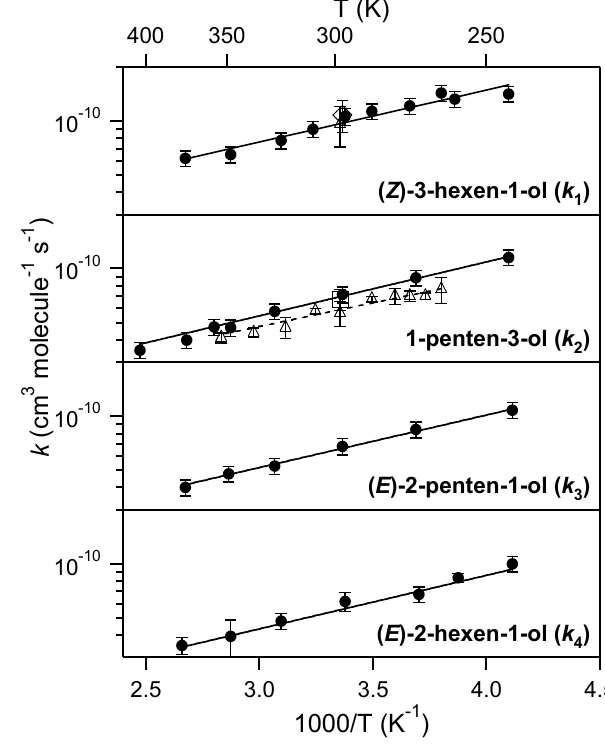
Figure 4 Fig. 4. Temperature dependent rate coefficient data for Reac- tions (R1)–(R4), Arrhenius plot, from this work ( • ). The error bars are the 2 σ uncertainty including estimated systematic errors. The lines are least-squares fits of the data to the Arrhenius expression, ln( k) =ln( A) – E /RT where the results are given in Table 6. For com- parison, results from previous studies, as described in the text, are Pseudo-first-order rate coefficient, k 0 , data plot- included: OH+(Z)-3-hexen-1-ol at room temperature by Atkinson ted versus the unsaturated alcohol concentration for ( Z) - et al. (1995) ( ♦ ) and Jim´enez et al. (2009) ( 4 ) ; OH+1-penten-3- 3-hexen-1-ol (( Z) -CH 3 CH 2 CH=CHCH 2 CH 2 OH) ( k 1 ) , ( E) -2- ol at room temperature by Orlando et al. (2001) ( (cid:3) ) and between hexen-1-ol (( E) -CH 3 CH 2 CH 2 CH=CHCH 2 OH) ( k 4 ) , 1-penten- 263 and 353K by Jim´enez et al. (2009) ( 4 ) . The results from the 3-ol (CH 3 CH 2 CH(OH)CH=CH 2 ) ( k 2 ) , ( E) -2-penten-1-ol (( E) - previous studies are also included in Table CH 3 CH 2 CH=CHCH 2 OH) ( k 3 ) at 244K ( 4 ), 297K ( (cid:13) ), and 374K ( (cid:3) ). The error bars are the 2 σ uncertainties from the fits to the individual OH decays (e.g. the data shown in Fig. 1). The lines are the least-squares fits of the data to Eq. (2) and the slope yields the bimolecular rate coefficient k .